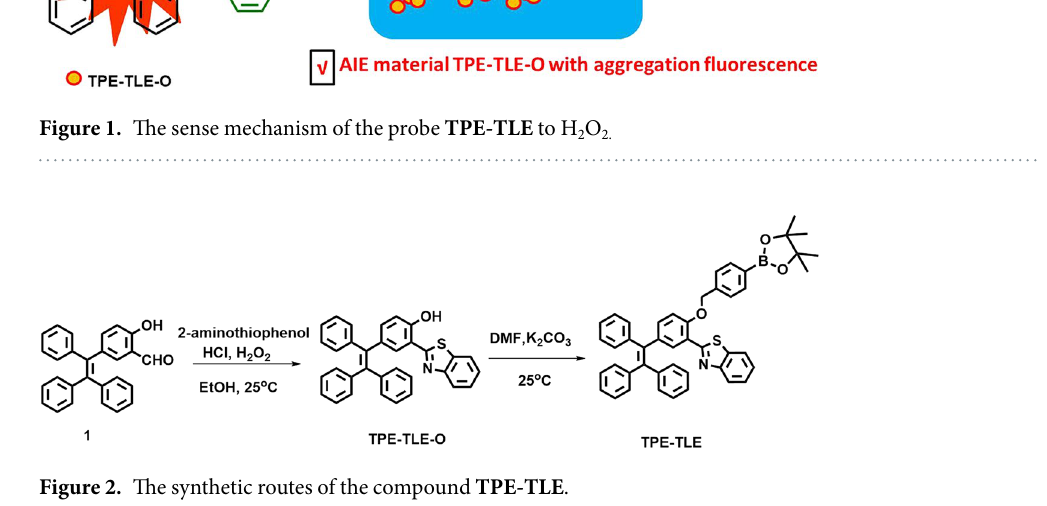
Figure 2. The synthetic routes of the compound TPE-TLE